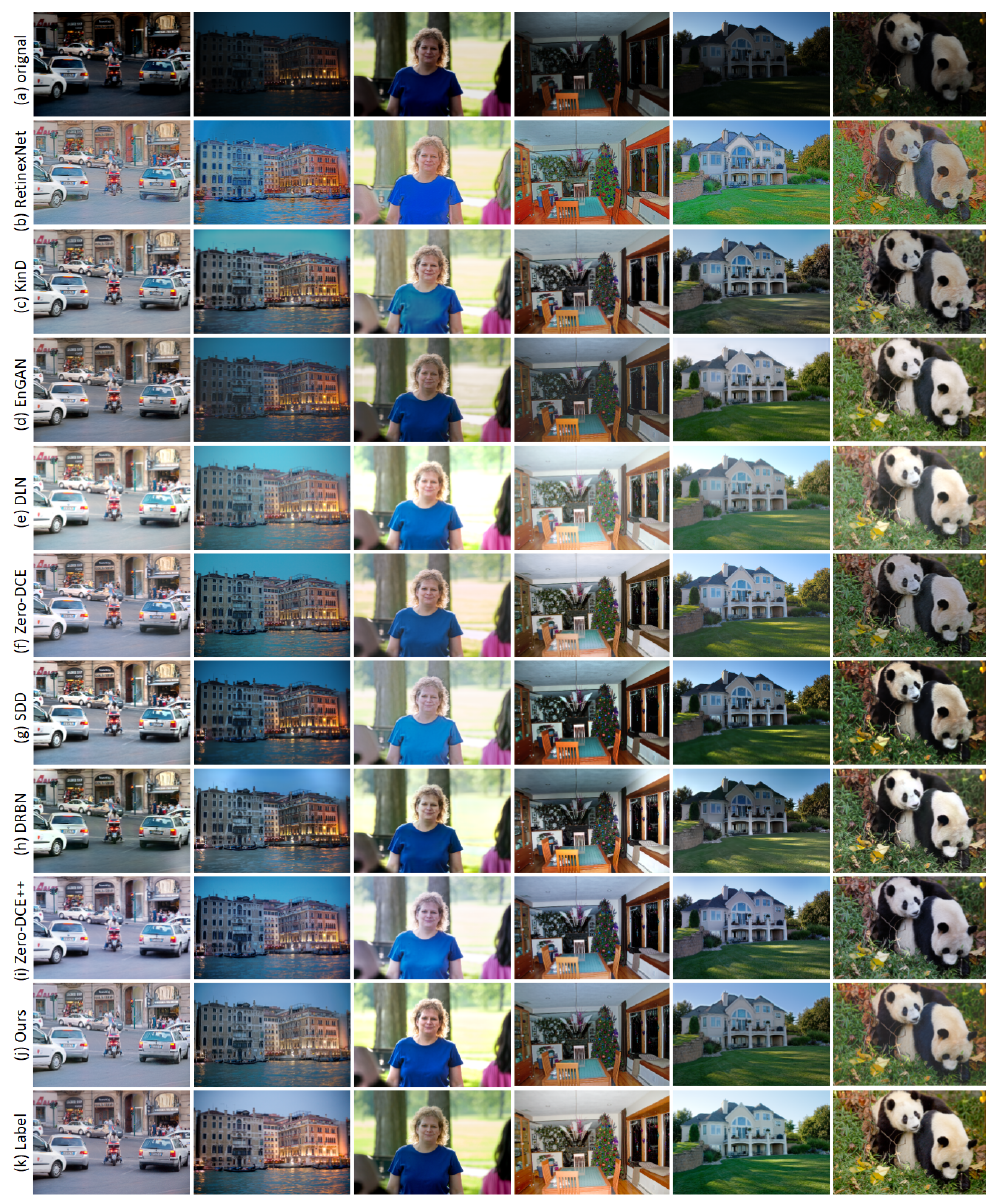
Figure 7. Example of comparison with CNN-based low-light image enhancement methods on the MIT [32]